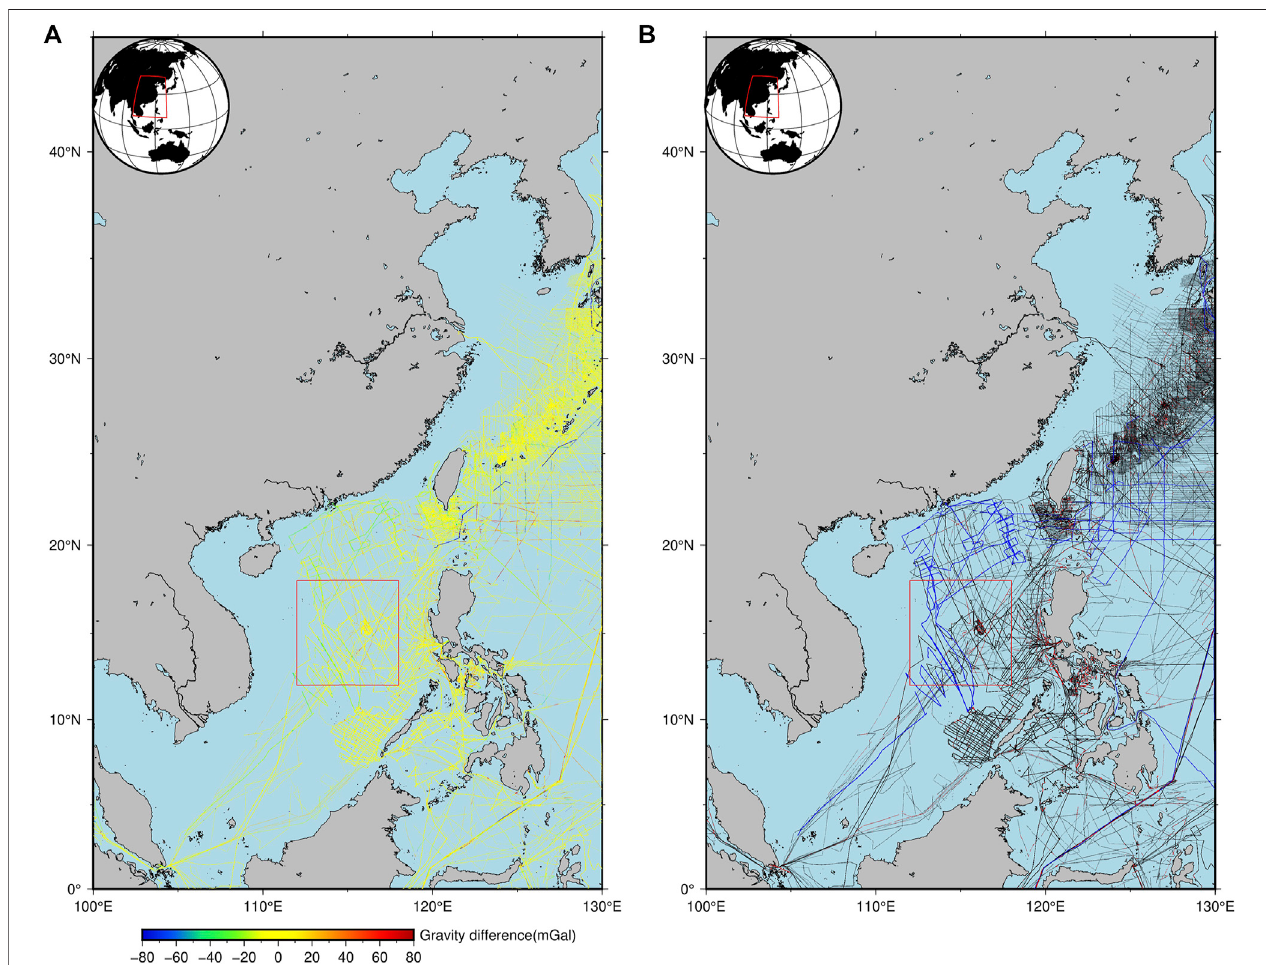
FIGURE 2 | Shipboard gravity measurements from the NCEI. (A) Distribution of gravity differences between EGM2008 and shipboard gravity. (B) The survey lines (blue)andpoints(red)withlargediscrepanciesthatarediscardedinthisstudy.Theremainingblackpointsarethecheckpointsforaccuracyevaluation.Theredrectangle is the South China Sea Basin, which is selected as a representative offshore basin to evaluate the accuracy of the gravity fi eld models.